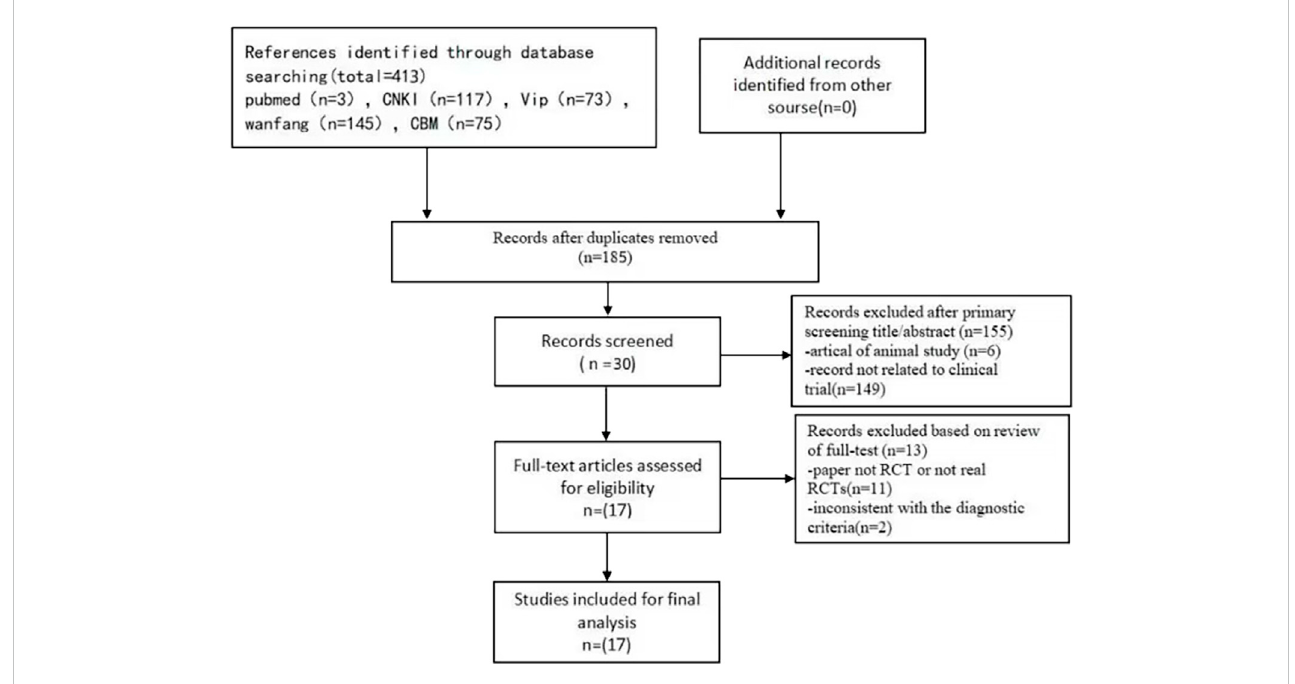
FIGURE 1 Flow diagram for the selection of articles for inclusion in the